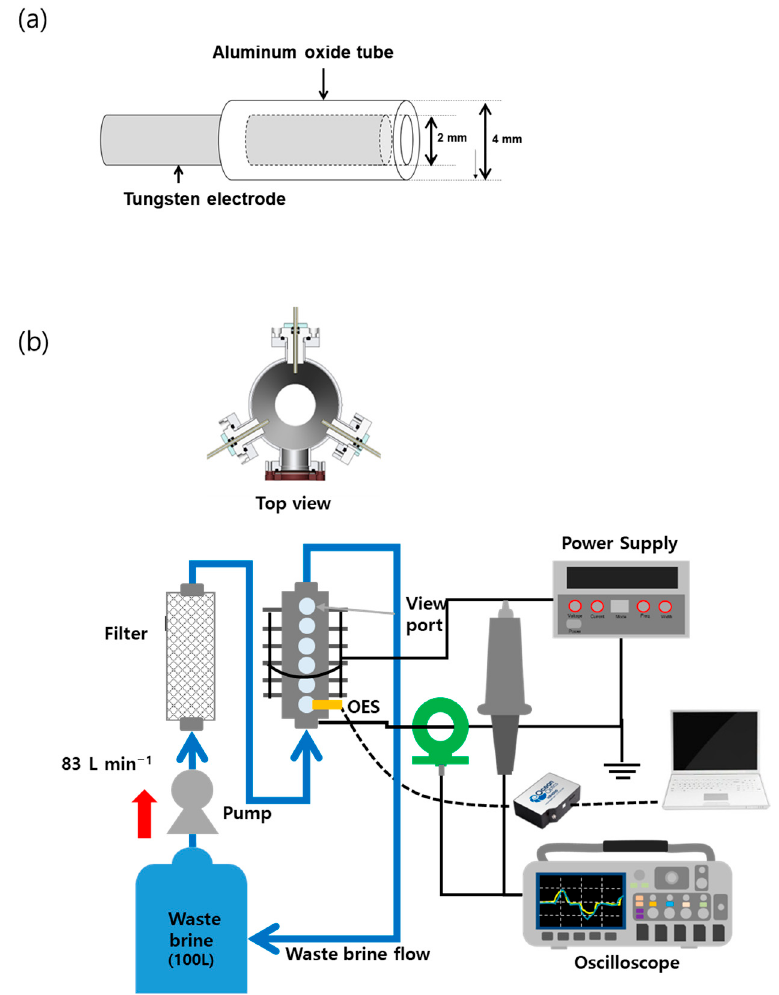
Figure 1. Experimental setup for the underwater plasma discharge device. ( a ) The shape of the capillary electrode; ( b ) configuration of the treatment system.